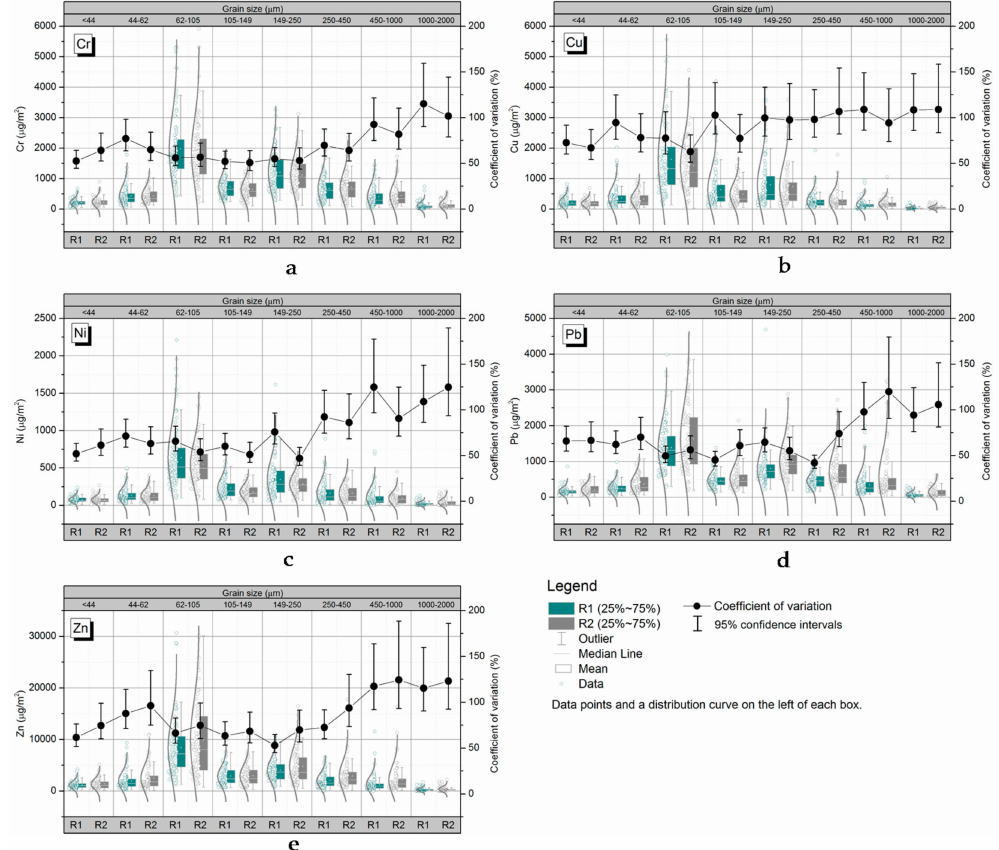
Figure 4. Grain-size heterogeneity in terms of GSF Load (%). GSF Load (%) is the contribution of the particles of a particular size to the overall level of metal contamination in a sample of sediment deposited on roads. Each Cv value shown is the mean ± the 95% confidence interval. ( a ) grain-size variability in Cr load; ( b ) grain-size variability in Cu GSF Load (%); ( c ) grain-size variability in Ni GSF Load (%); ( d ) grain-size variability in Pb GSF Load (%); ( e ) grain-size variability in Zn GSF Load